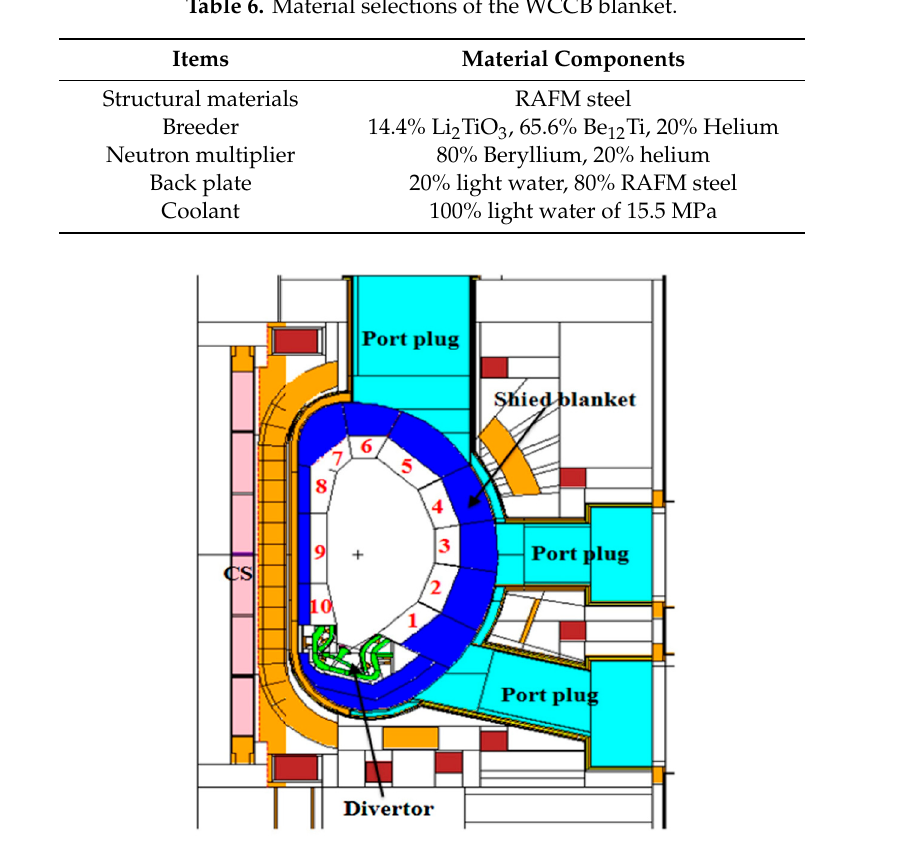
Figure 13. Radial layout of the 1D WCCB neutronics model.